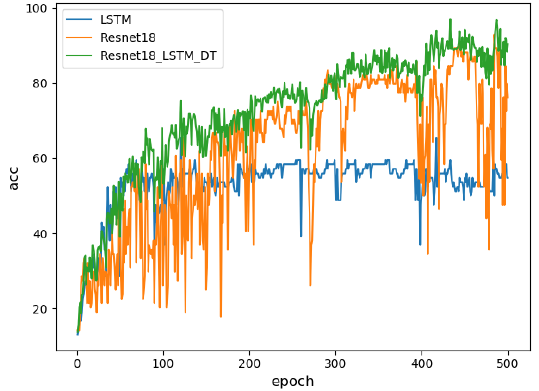
Figure 17. Comparison of the classification effect of using the hybrid model and using Resnet18 or LSTM alone.